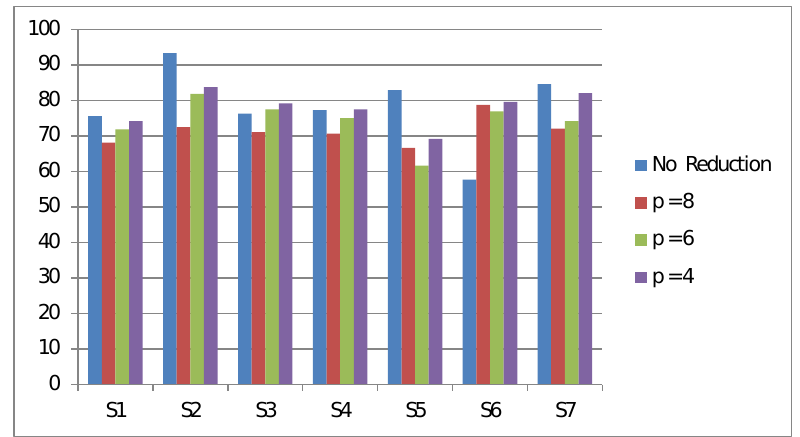
Figure 5. Accuracy comparison by various levels of dimensionality reduction.